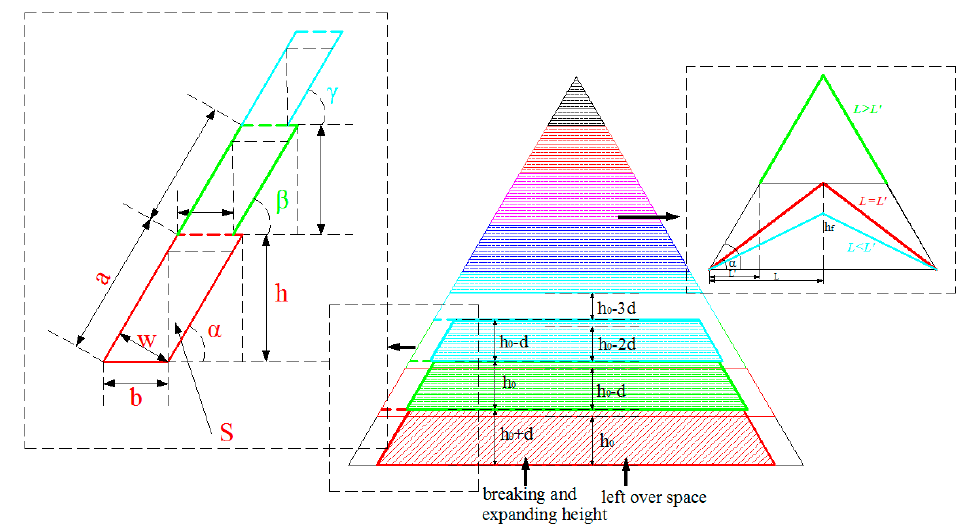
Figure 4. Schematic diagram of the parallelogram fracture passages generated at both ends of the trapezoidal broken model.